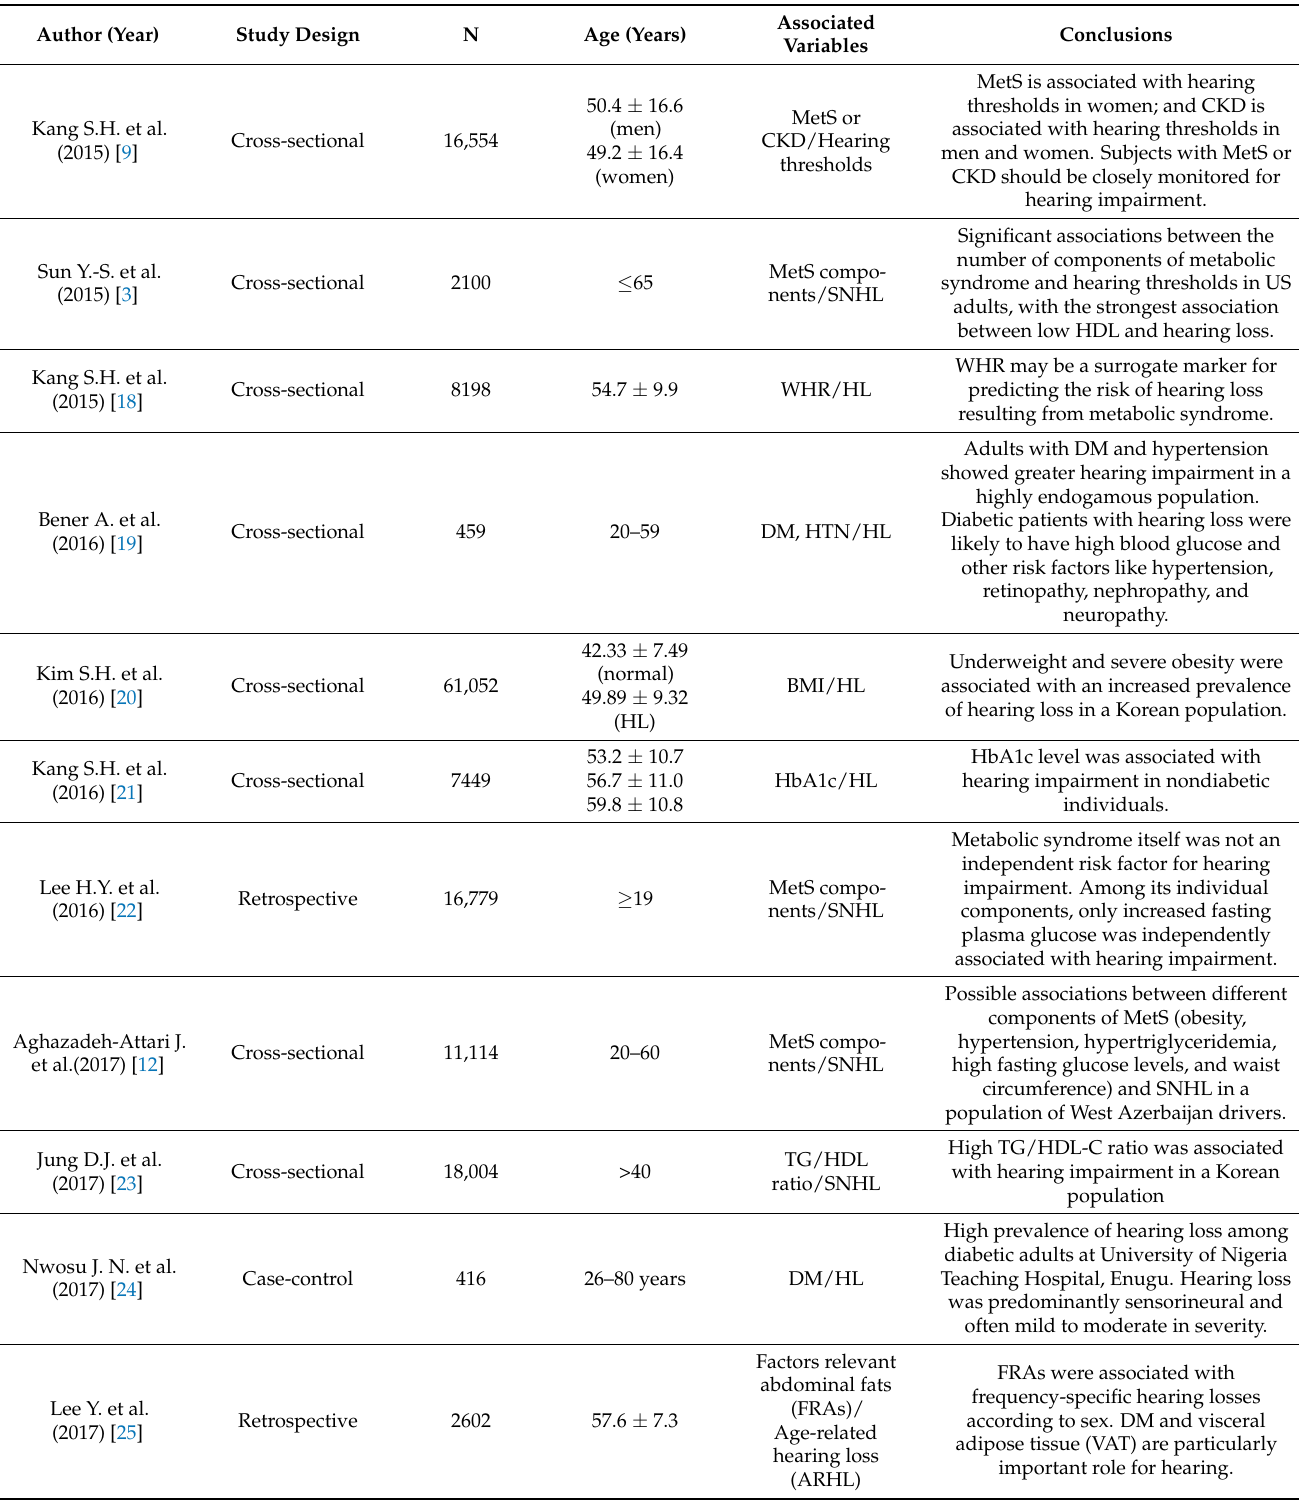
Table 1. Studies assessing the association between hearing loss and metabolic